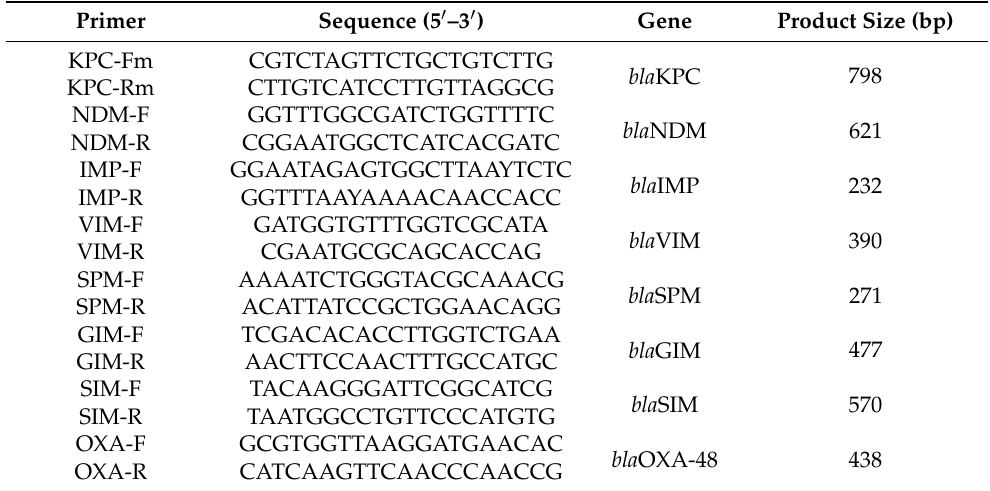
Table 6. Oligonucleotides used in this study. Primer Sequence (5 (cid:48) –3 (cid:48)